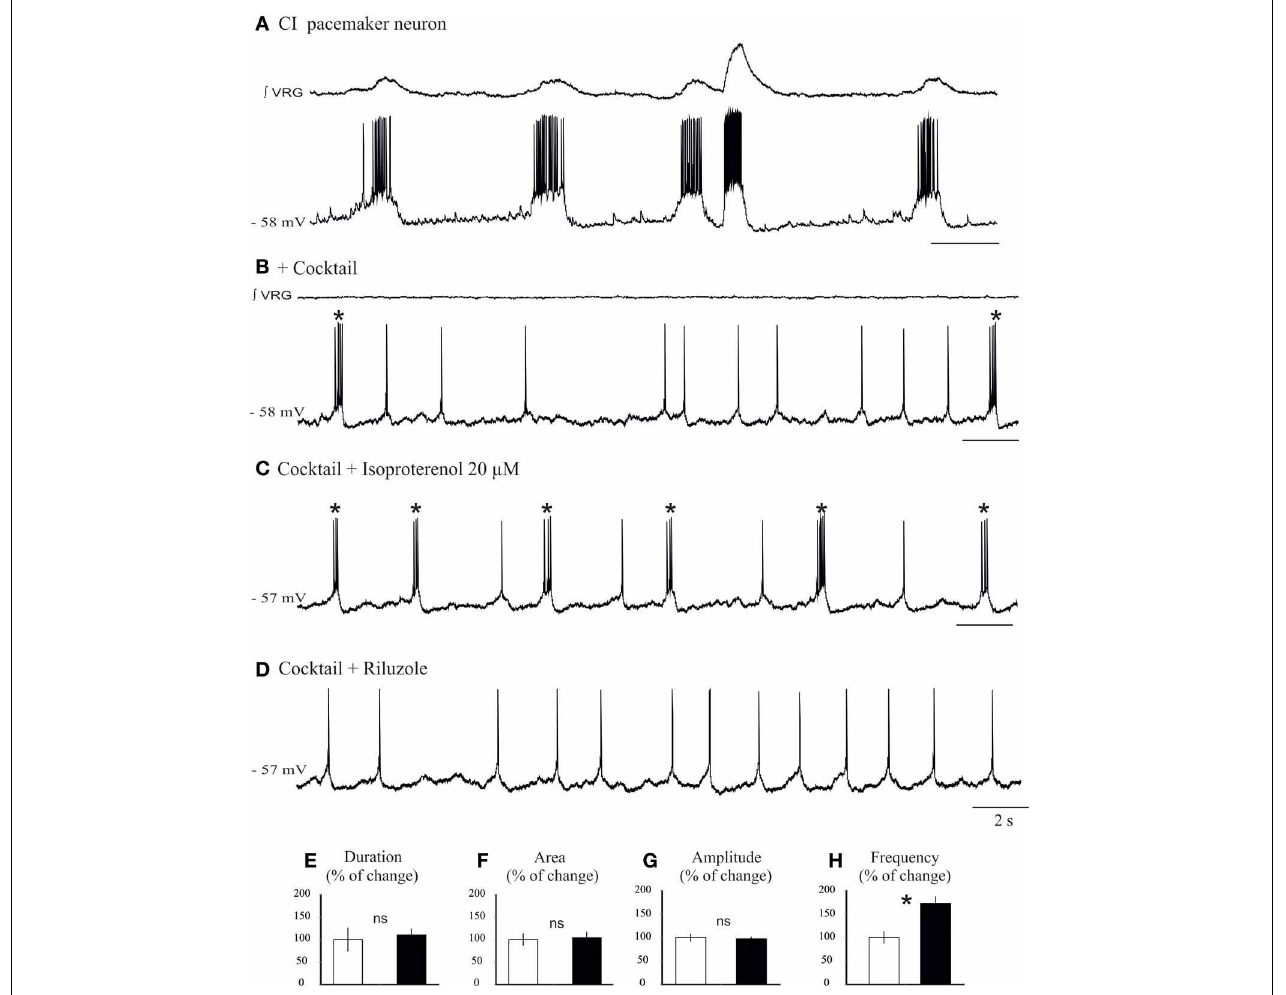
FIGURE 7 | Isoproterenol increases the burst frequency of I Nap pacemaker neurons. (A) Recording of an inspiratory pacemaker neuron that bursts during fictive sigh activity. (B) This neuron continues to burst in synaptic blockade (cocktail). (C) Application of isoproterenol 20 μ M increases the burst frequency of I Nap pacemaker neuron. (D) Application of riluzole